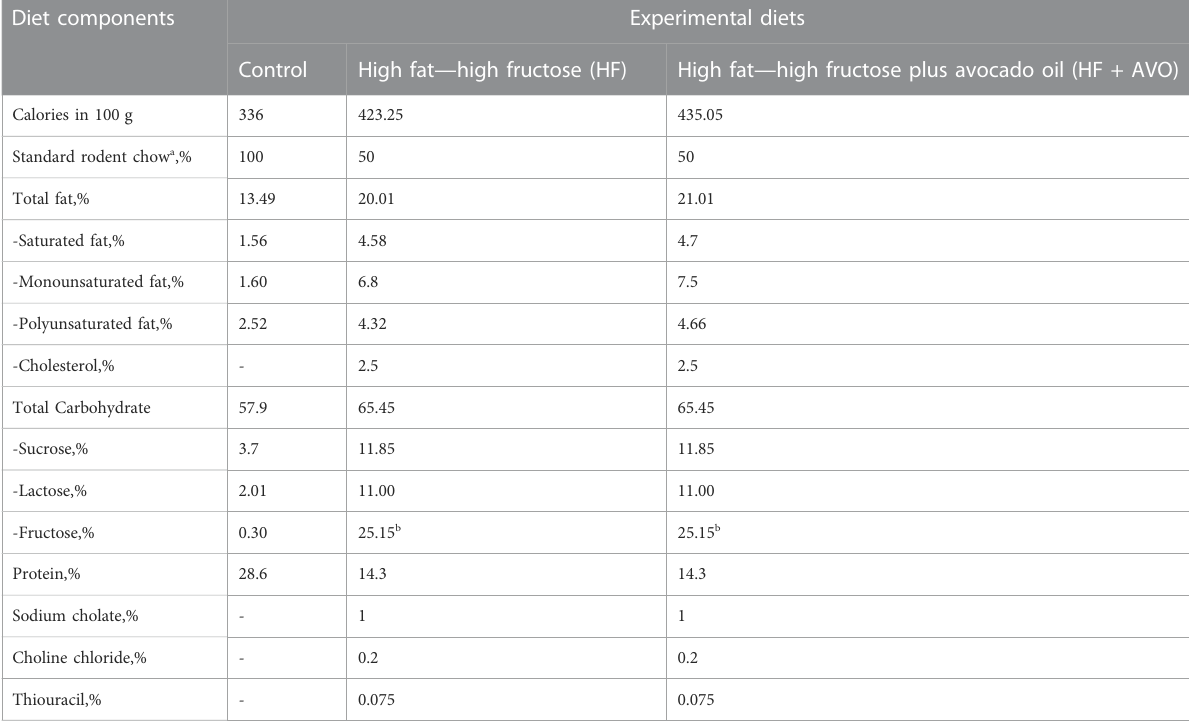
TABLE 1 Experimental groups and preparation of